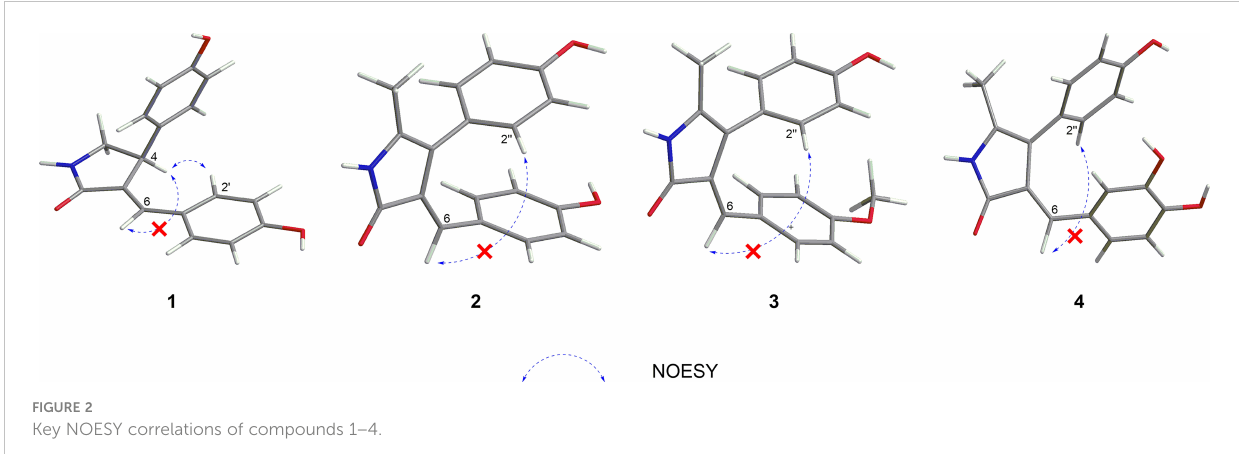
FIGURE 2 Key NOESY correlations of compounds 1 −